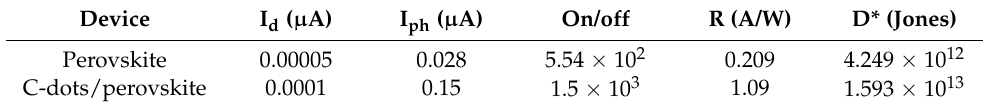
Table 2. Performance summary of the perovskite and C-dot/perovskite